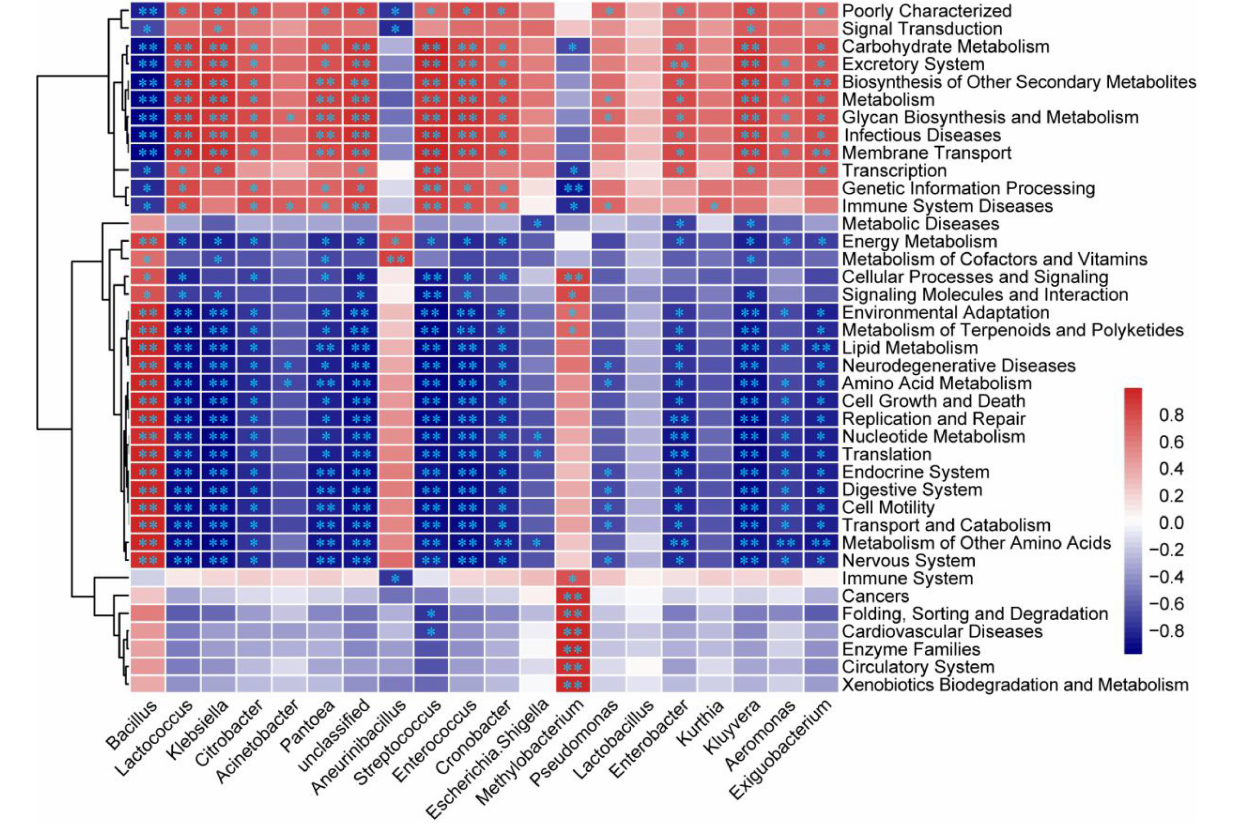
FIGURE 6 | Heatmap of correlations between the bacteria and KEGG function pathways in the non-post fermented Shuidouchi. The Pearson correlation coefficient r between the bacteria and function pathway ranged from –1 to 1, where the positive correlation was r > 0, and the negative correlation was r < 0. ∗ Represents p < 0.05 and ∗∗ represents p <